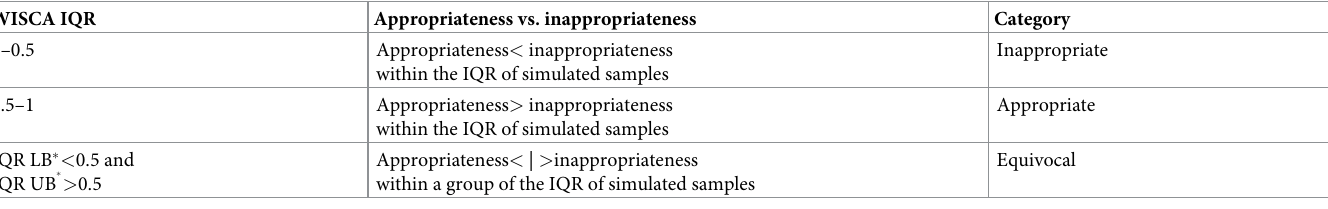
Table 1. Categorization of antibiotics according to the interquartile ranges of WISCA values. WISCA IQR Appropriateness vs.